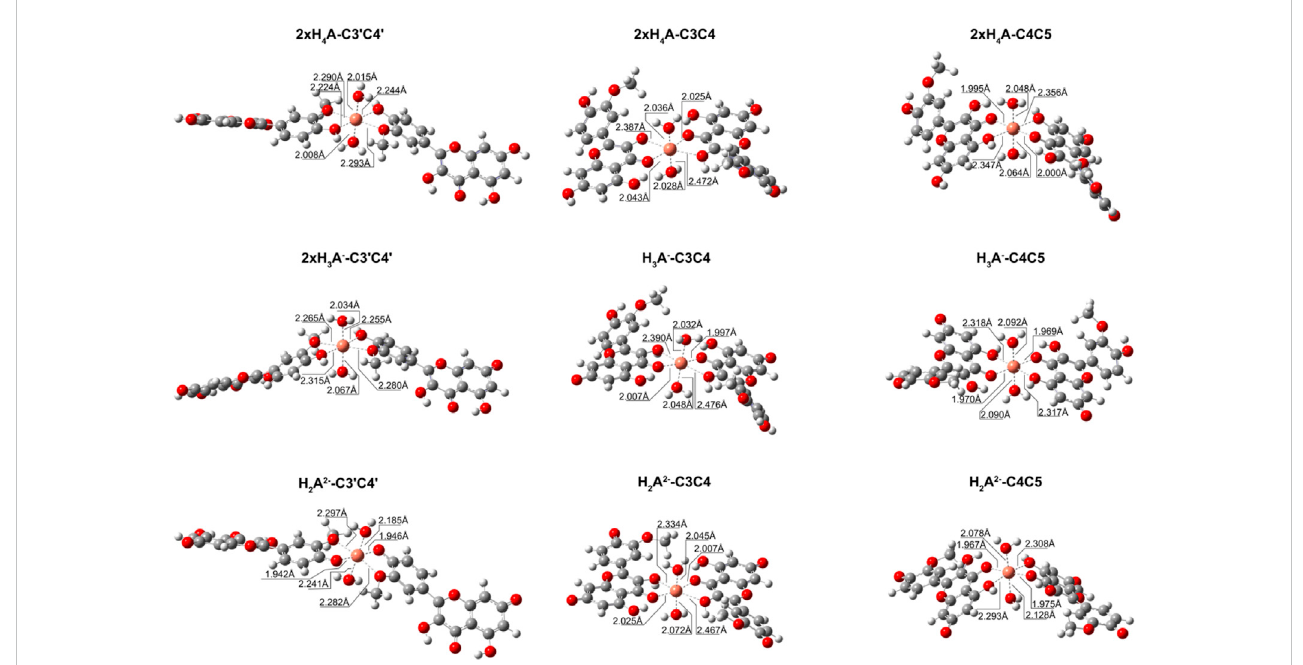
Structures for the most stable 1:2 complexes between Cu 2+ and the neutral and charged species of isorhamnetin.